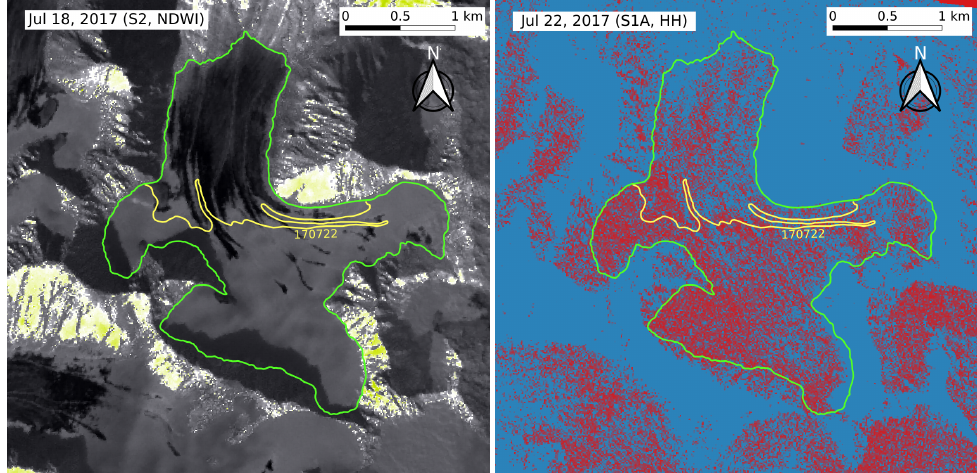
Figure 7. Comparison of the spaceborne multispectral image acquisition from Sentinel-2 ( left , collected 18 July 2021 with dark areas identified as bare ice in the lower part of the glacier or water- soaked snow in the upper part, and bright areas as snow) and the RADAR reflectivity map at similar polarization (HH) from spaceborne microwave RADAR Sentinel 1A ( right , collected 22 July 2017). Blue indicates strong reflected microwave intensity and red low reflected intensity on the binary map of the RADAR backscattered power map ( right ). Notice how some of the fine structures along the ice–snow limit on the multispectral image ( left ) are also visible on the RADAR image ( right ). A detailed analysis of Figure 8 is as